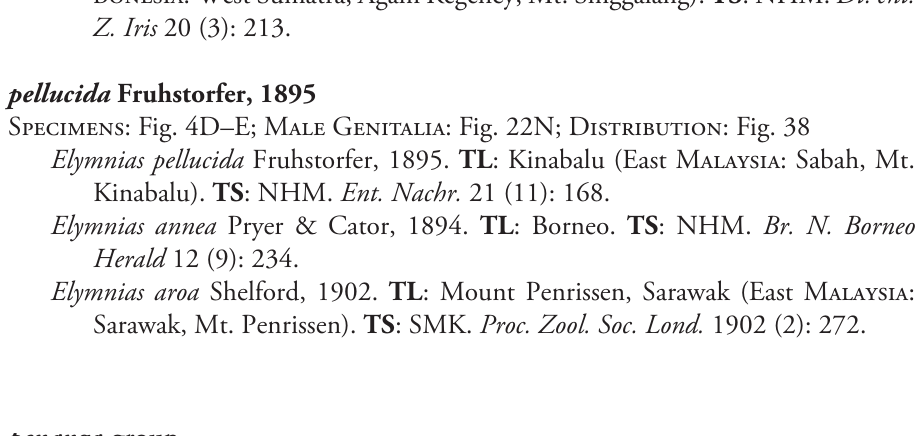
Specimens: Fig. 4F–L; Male Genitalia: Fig. 22O; Distribution: Fig.